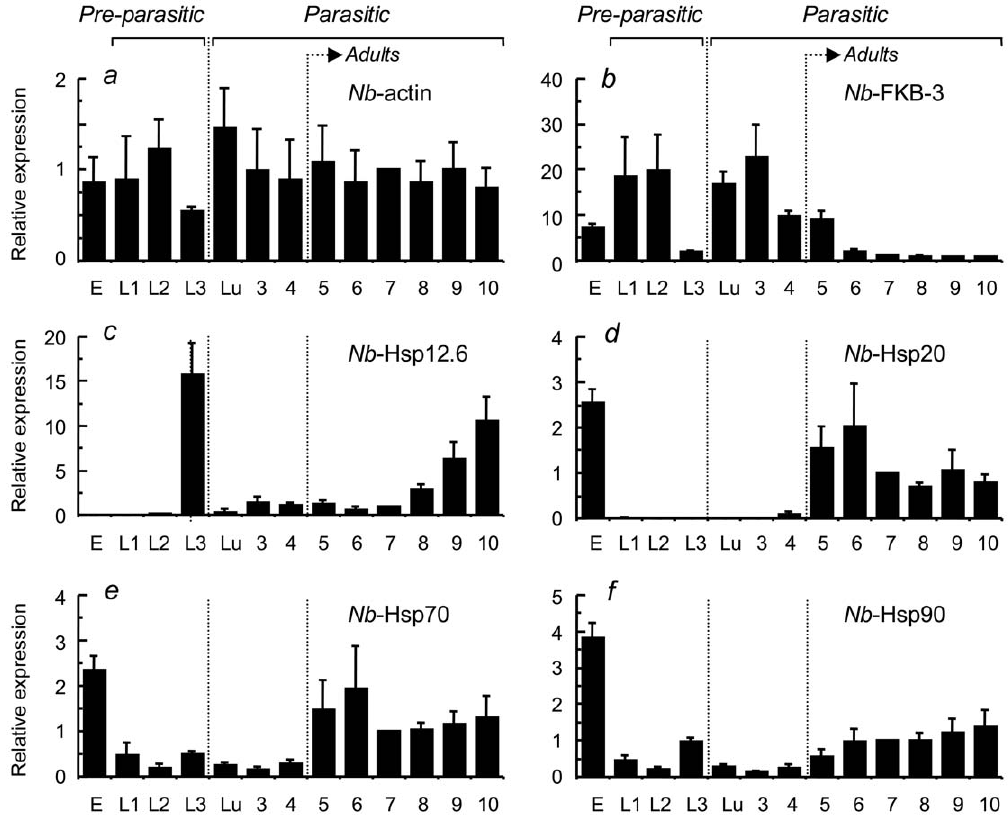
Figure 2. Temporal gene expression patterns during the lifecycle of N.brasiliensis . E, eggs; L1–L3, L1–L3 stage larvae in fecal culture; Lu, lung stage-L3 larvae; 3–12, intestinal worms recovered at the indicated days after infection. The pre-parasitic stage data are shown as the mean and SD of worm populations recovered from 3 batches of fecal cultures. The parasitic stage data are shown as the mean and SD of worm populations recovered from 3 SD rats. Except Nb -actin ( a ), the levels of which were normalized to RNA quantities, all gene expression levels ( b–f ) were normalized to those of Nb -actin. The values observed at 7 days PI are expressed as 1.0.